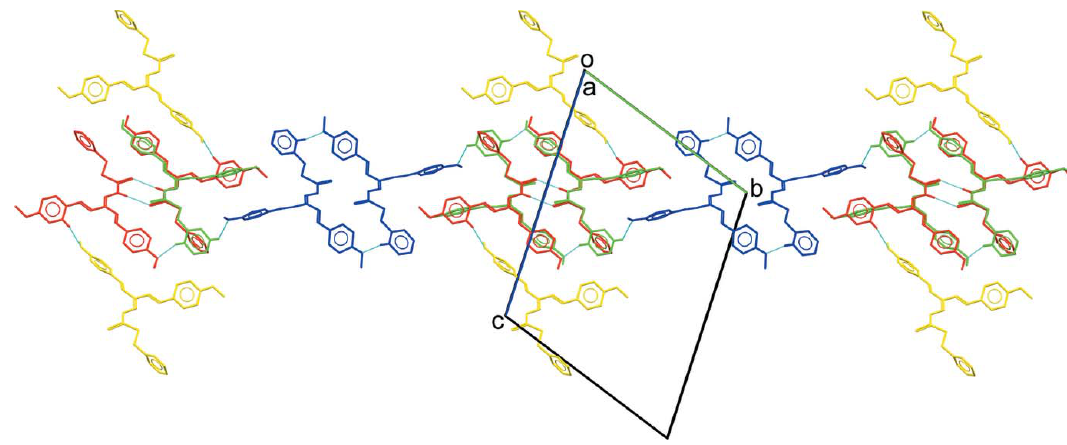
Figure 4 A partial packing diagram of the title compound showing molecules linked into chains by N—H (cid:3)(cid:3)(cid:3) S and C—H (cid:3)(cid:3)(cid:3) O interactions.